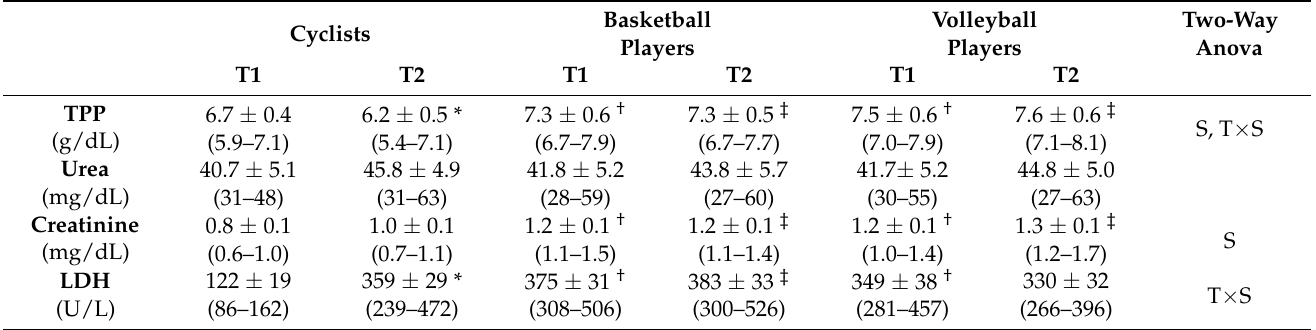
Table 2. Changes in plasmatic parameters in cyclists, basketball and volleyball players at the end of T1 and at the end of